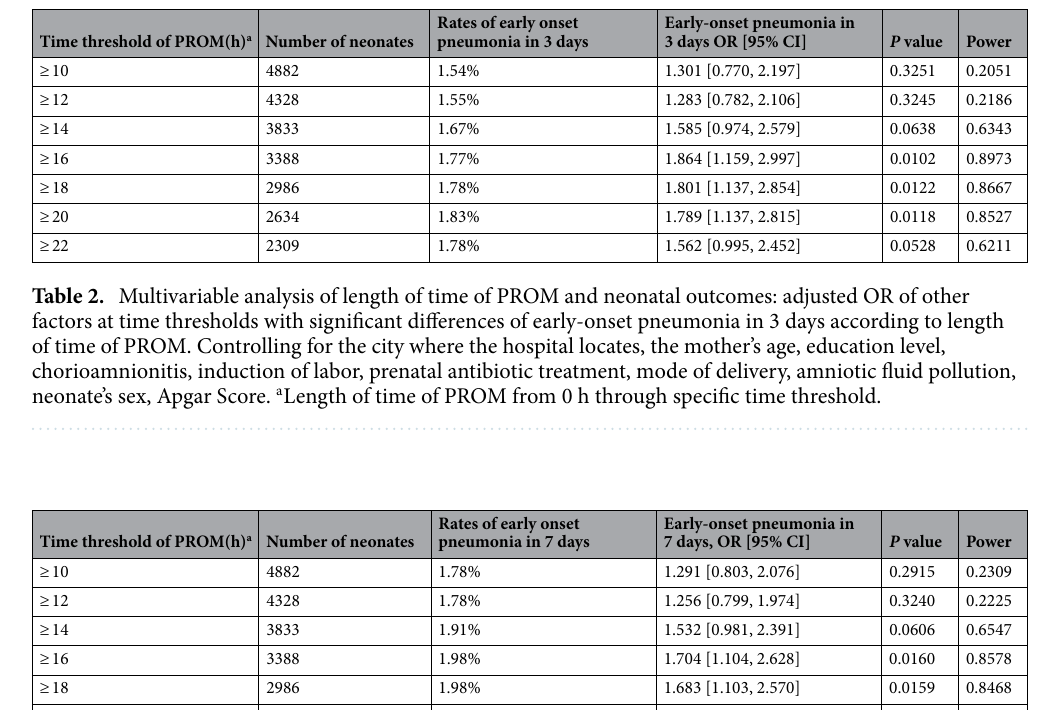
Rates of early onset pneumonia in 3 days